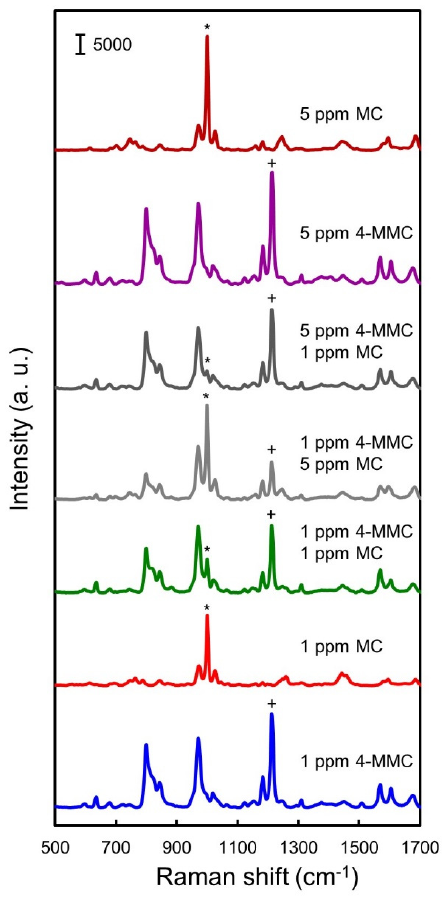
Figure 3. SERS detection of MC, 4-MMC, and mixtures of MC and 4-MMC in water. SERS spectra of 1 ppm MC, 5 ppm MC, 1 ppm 4-MMC, 5 ppm 4-MMC, 5 ppm 4-MMC plus 1 ppm MC, 1 ppm 4-MMC plus 5 ppm MC, and 1 ppm 4-MMC plus 1 ppm MC. The characteristic Raman peak of MC at 1000 cm − 1 and the characteristic Raman peak of 4-MMC at 1212 cm − 1 are marked with “*” and “+”, respectively.